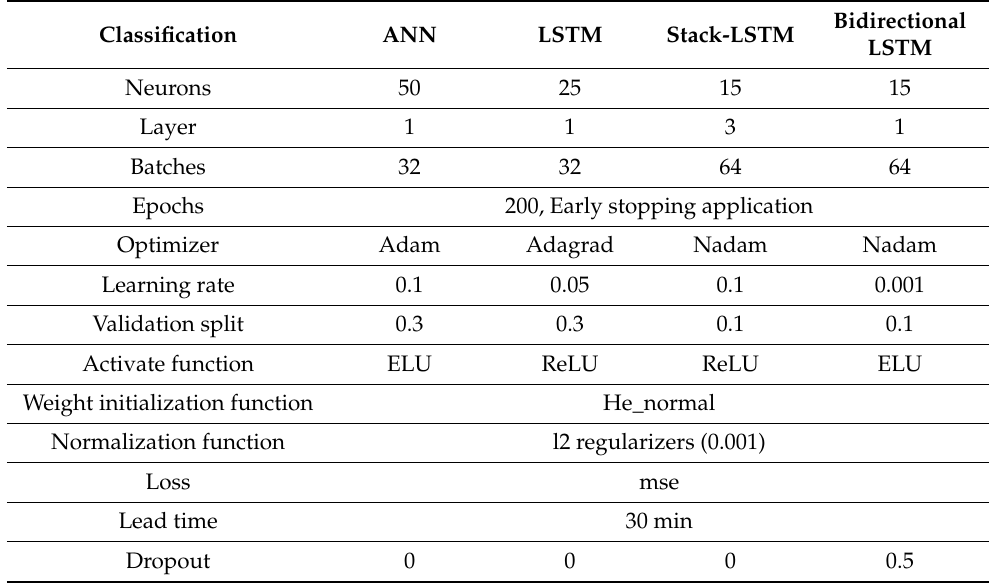
Table 6. Adopted hyperparameters by the random search method.